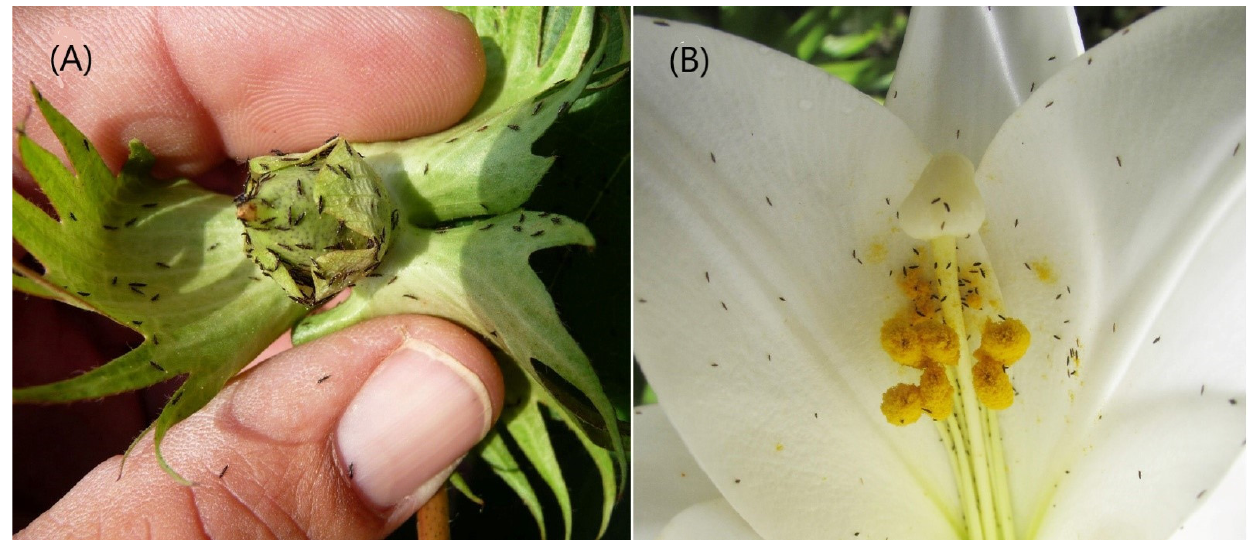
Figure 1. Aggregations of adult thrips. ( A ) Black Plague Thrips ( Haplothrips froggatti ) on cotton bud. ( B ) Thrips parvispinus on garden Lily flower.